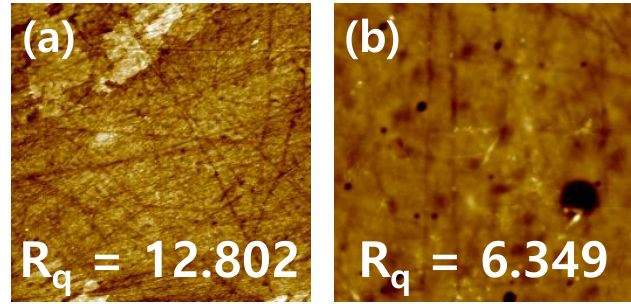
Figure 9. SEM analysis of ( a ) ref sample and ( b ) Ce sample. Figure 10. AFM analysis of ( a ) ref sample and ( b ) Ce sample.